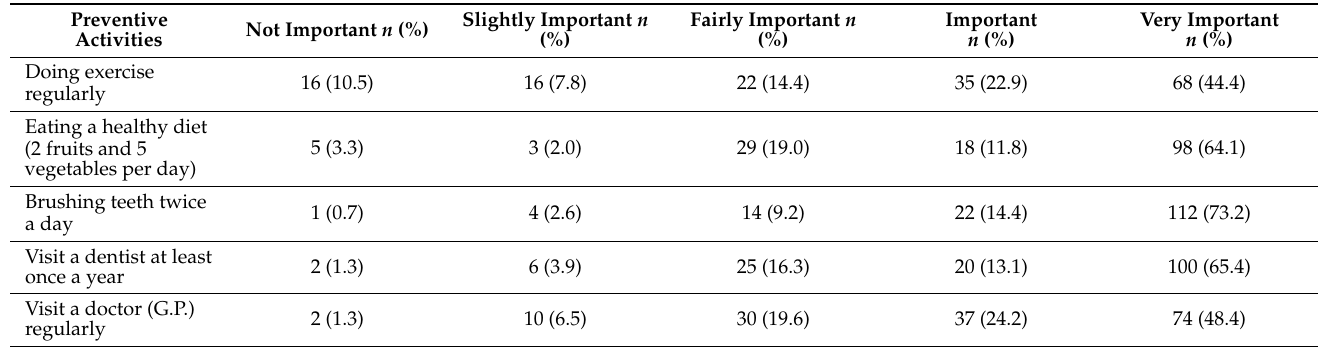
Table 4. Self-rated importance of various activities in the prevention of oral